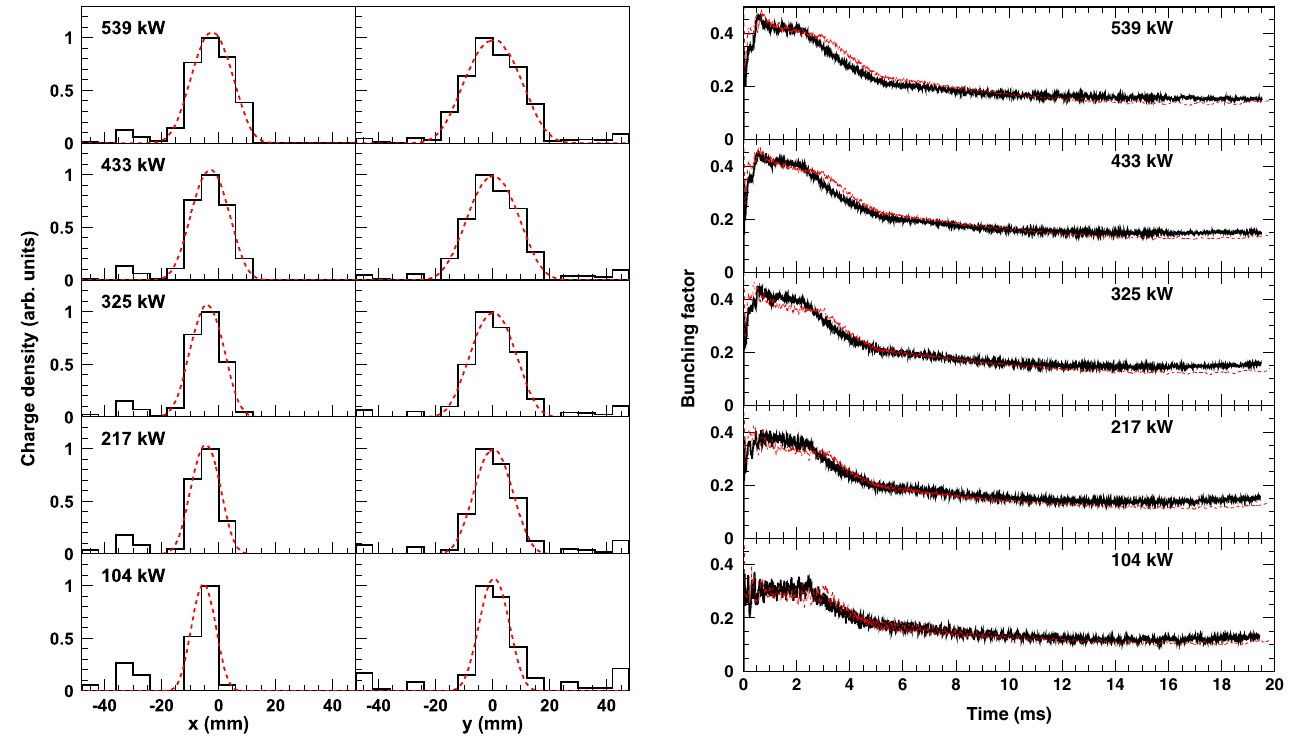
FIG. 14. Bunching factors measured with the injection painting parameter of ID 8 for various beam intensities from 104 to 539 kW, where the dashed red curves are the corresponding numerical simulation results.